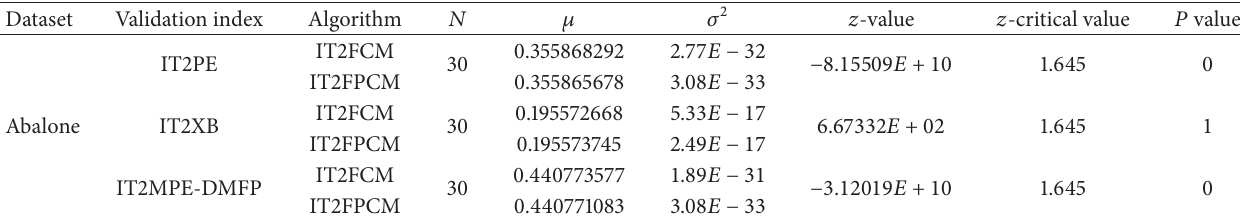
Table 24: Hypothesis test for IT2PE, IT2XB, and IT2MPE-DMFP indices of validation for the Abalone dataset clustering.